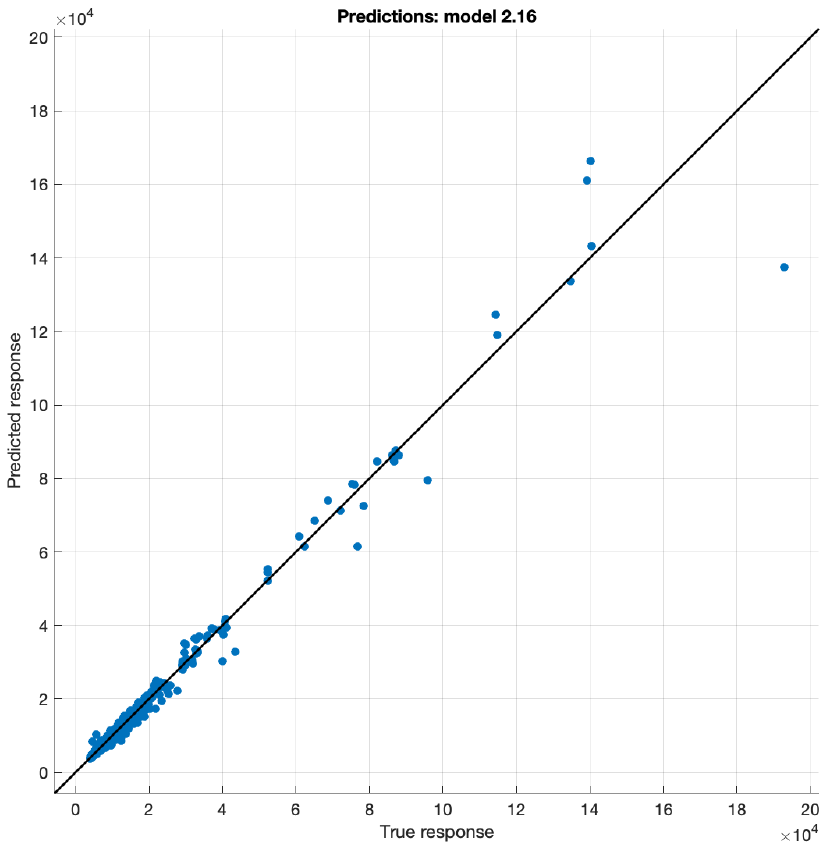
Figure 3. Predicted vs. actual annual mean salary across economic activities using Bayesian